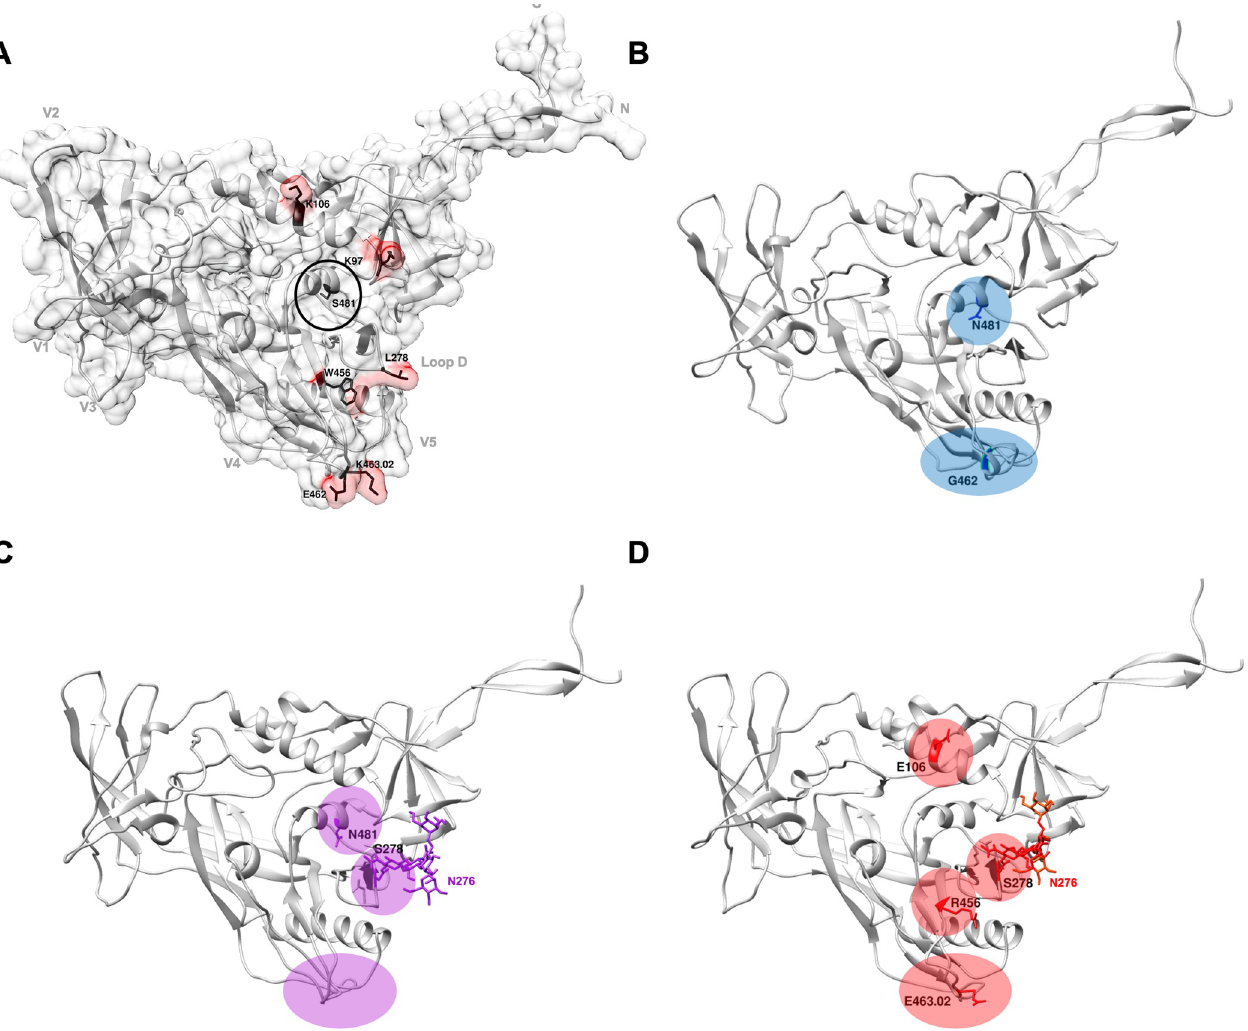
Fig 3. Models of the CAP239 gp120: effect of ADCC and neutralization escape mutations on Env structure. Trimer models of CAP239 T/F and Envs from each of the three evolutionary pathways were constructed using Modeller [53] and the best scoring model was visualised using Chimera [54]. A single gp120 monomer from the trimer of the T/F or Envs from each pathway were used for further analysis. GlyProt [55] was used to add basic glycans (N276 in pathway two and three). (A) The contact surface was modelled onto the CAP239 T/F gp120 (grey) with any key residue surfaces shown in red. Structural landmarks (grey) and key residues in CAP239 viral evolution (black) are labelled on the CAP239 TF gp120. Changes characteristic of evolution are shown in (B) blue for pathway one (CAP239 19-7F4), (C) purple for pathway two (CAP239 19-7C2), and (D) red for pathway three (CAP239 19-7H2; pathway